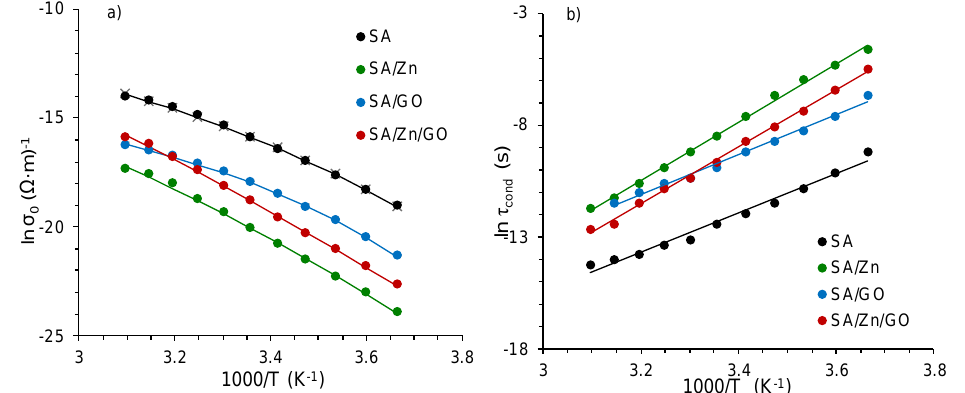
Figure 8. ( a ) Temperature dependence of dc-conductivity, σ 0 , obtained from σ’ from 0 to 50 °C; ( b ) temperature dependence of the relaxation time related to the conductivity process, τ cond , in the same temperature range. Solid lines show VFT ( a ) and Arrhenius ( b ) fitting.